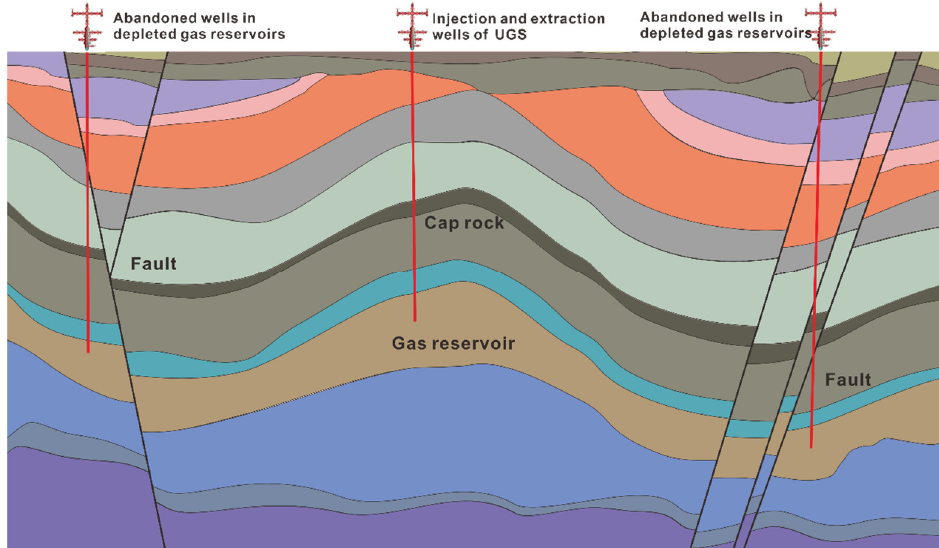
Figure 1. Schematic diagram of depleted gas reservoir type